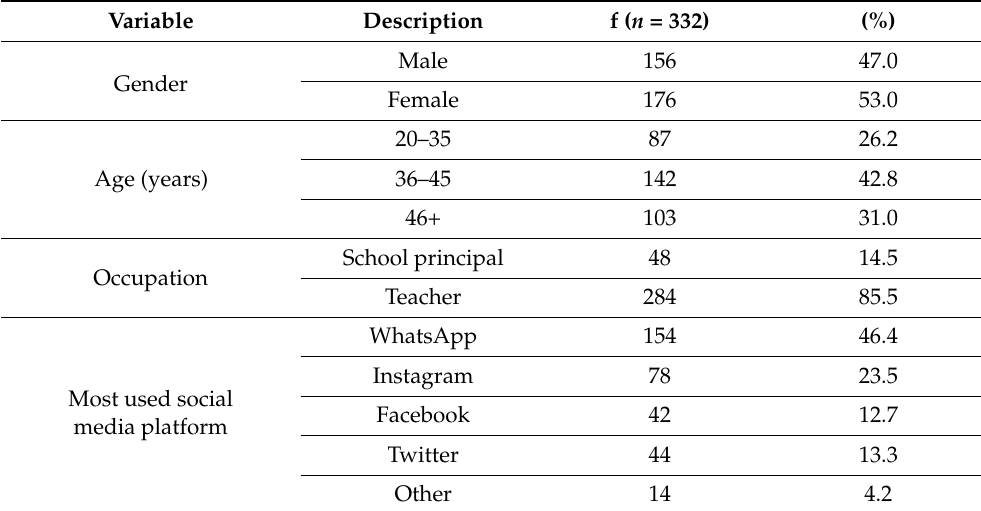
Table 1. Sociodemographic profile of the